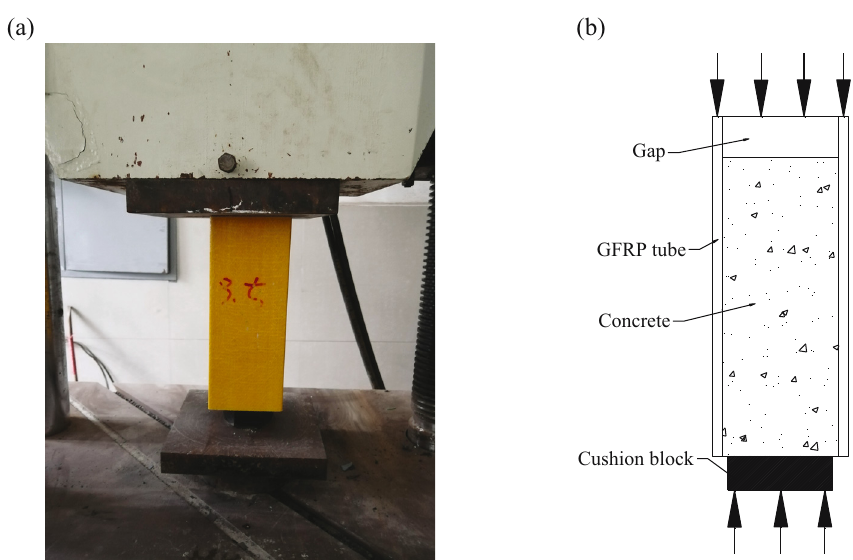
Figure 5: Loading diagram of the specimen: ( a ) loaded specimen and ( b ) diagrammatic sketch of loading.